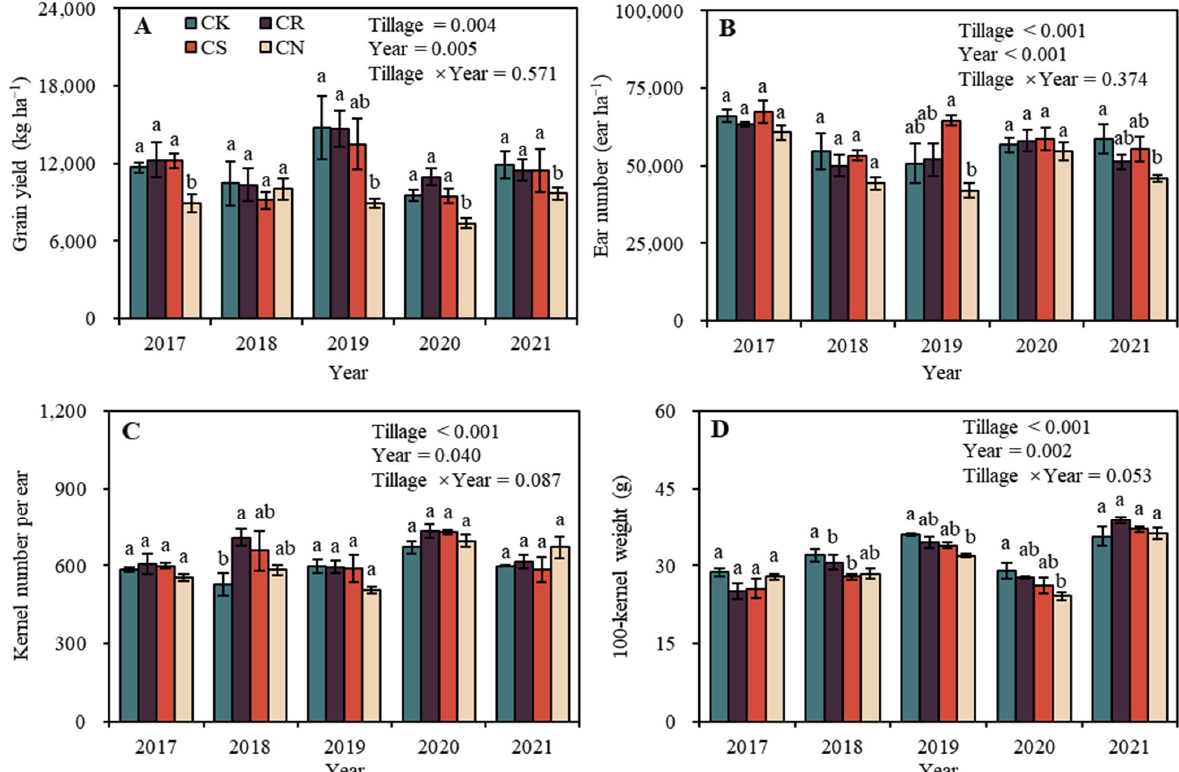
Figure 2. Maize yield ( A ), ear number ( B ), kernel number per ear ( C ) and 100-kernal weight ( D ) as affected by tillage regimes during 2017 to 2021. CK, rotary tillage without straw returning; CR, rotary tillage with straw incorporation; CS, subsoiling tillage with straw mulching; CN, no tillage with straw mulching. Bar means the standard error. Different letters among the treatments for each year indicate a significant difference at p < 0.05.